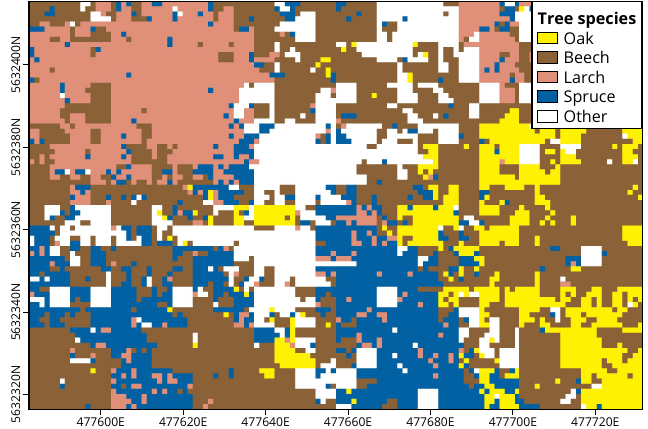
Figure 9. Result of the grid application. Tree colors correspond to the colors used in map illustrations of the Hessian forestry management. White areas mark regions where the model was not applicable. Coordinates are given in UTM zone